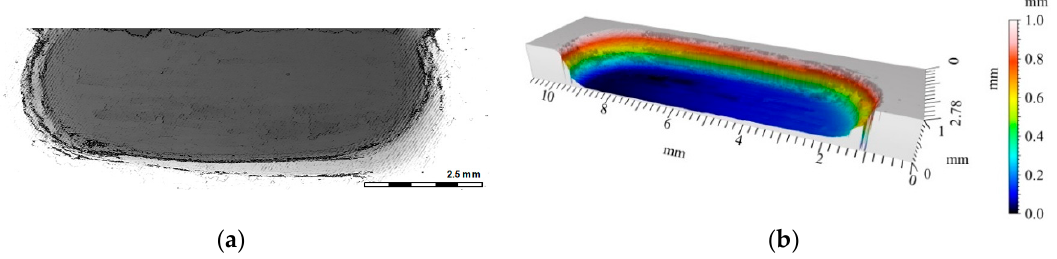
Figure 13. View of the wear track in the C5 single composite layer (marked with a red line in Figure 6b) after dry sliding: ( a ) Digital image; ( b ) Cross-section through 3D view. Materials 2018 , 11 , x FOR PEER REVIEW